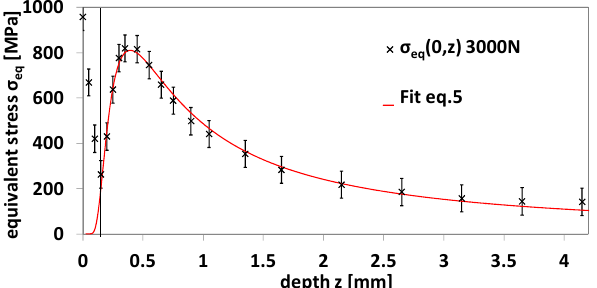
Figure 4. Fit for experimental data of equivalent stress distribution σ eq ,3000N (0, z ) in depth during loading.